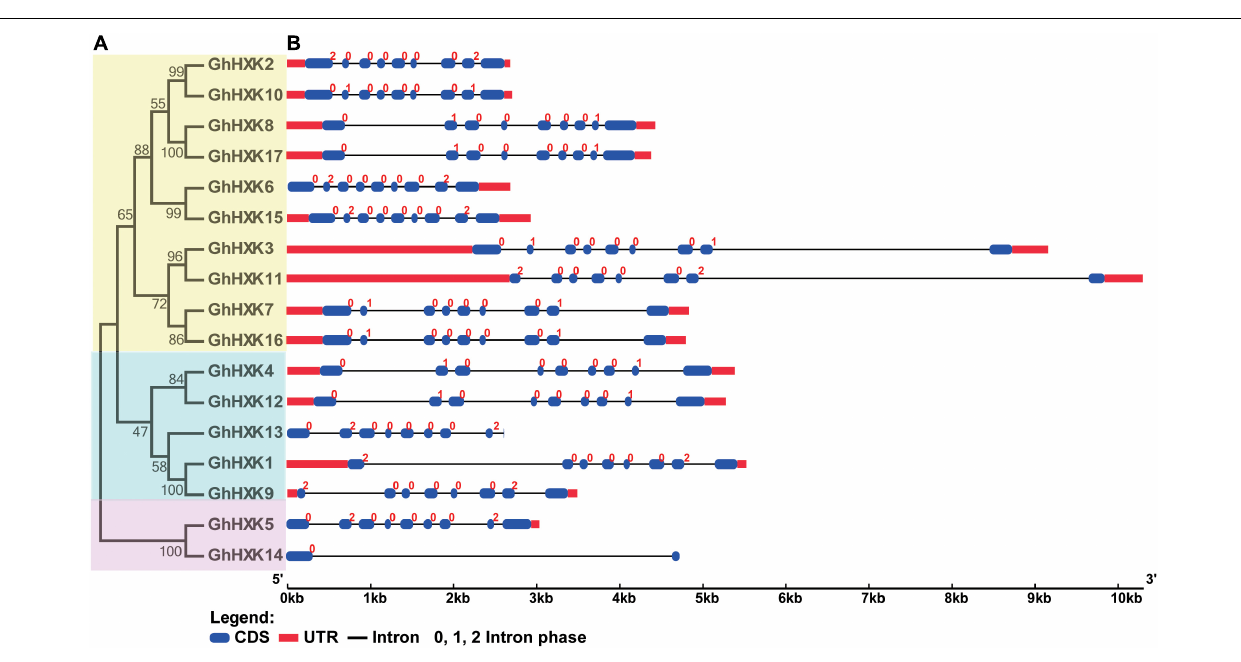
HXKs in cotton species are conservative and have